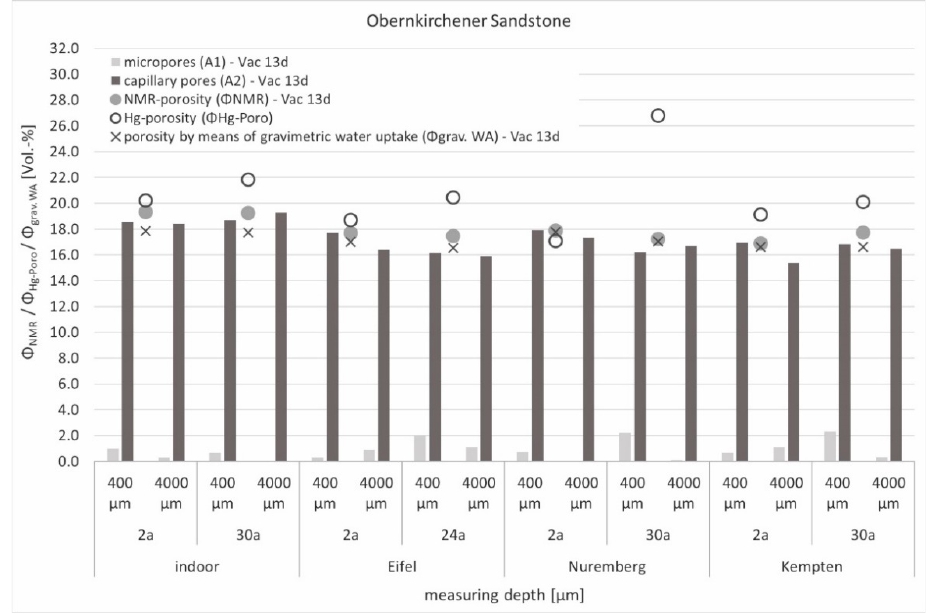
Figure 10. Distribution of micro (A1) and capillary (A2) pores within the Obernkirchener Sandstone samples measured in the near-surface area (400 µm) and the sample depth (4000 µm), and presentation of the resulting NMR-porosity ( Φ NMR ) (averaged over the entire depth of the samples) in comparison with the detected porosity measured using mercury porosimetry ( Φ Hg-Poro ) and gravimetric water uptake ( Φ grav . WA ).